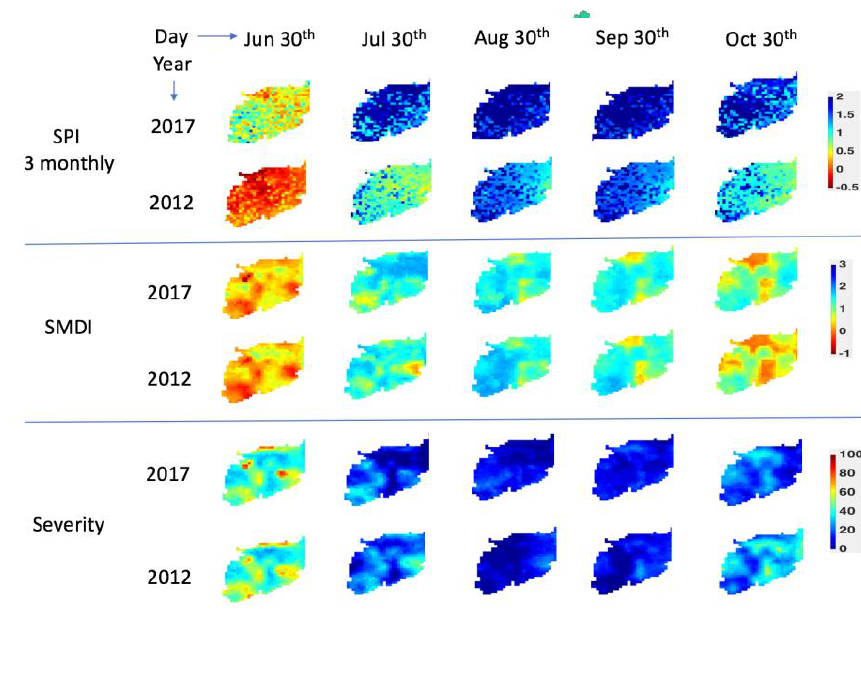
Figure 9 : Rice yields for years 2012 and 2017 for the three states (CG, OD, and